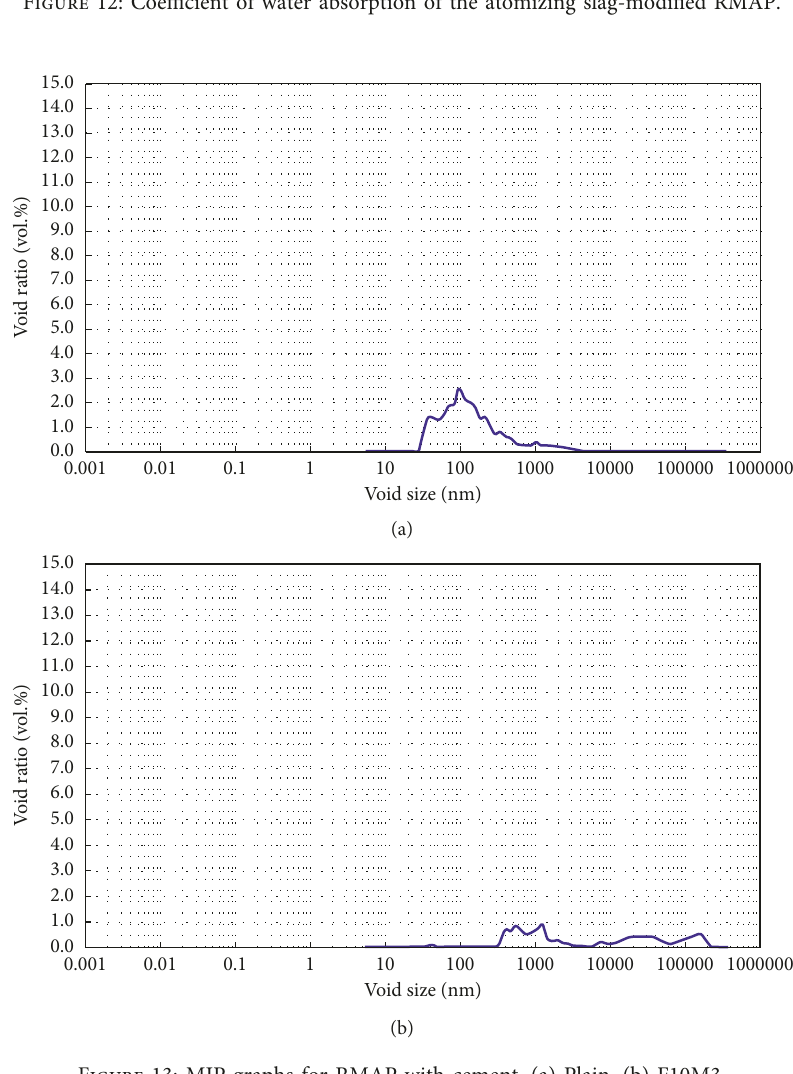
Figure 13: MIP graphs for RMAP with cement. (a) Plain. (b)